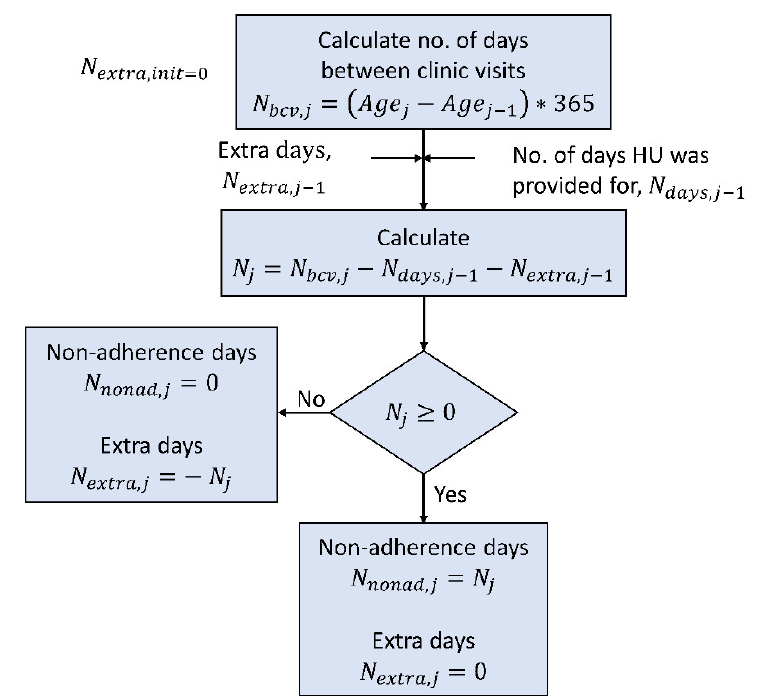
Figure 4. Flowchart to calculate the number of non-adherent days for j th visit from the pharmacy refill record. The pharmacy refill record contains the total dose given to the participant at every visit and the number of days for which it is given. This process assumes that the participant takes the capsule if they have it. Age j − 1 and Age j —age in years at j − 1th and j th visit; N bcv , j —number of days between clinic visits; N days , j − 1 —number of days HU was provided at j − 1th visit; N extra , j —number of extra days for which capsules are available at j th visit; N extra , init —number of initial extra capsules is assumed to be zero; N nonad , j —number of non-adherence days at j th